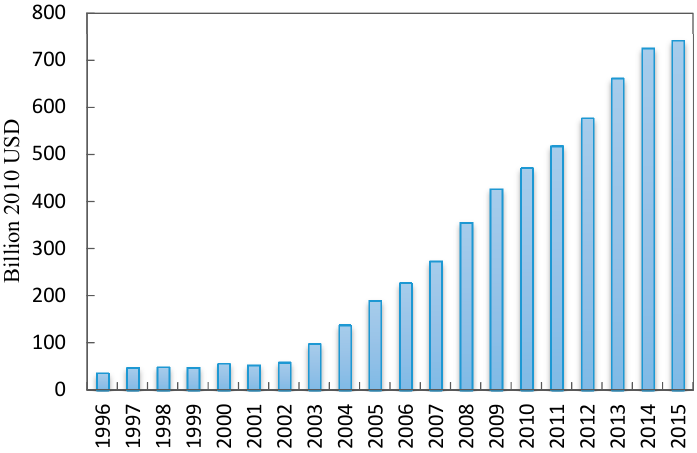
Figure 3. Investment of energy industry in China from 1996 to 2015 [31].